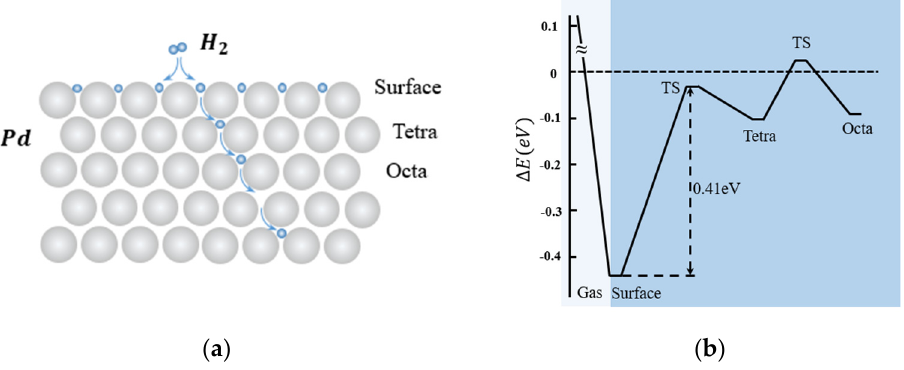
Figure 1. ( a ) Illustration of hydrogen adsorption in Pd (100) [16]; ( b ) diagram of the potential energy profile of hydrogen-absorption [17]. Copyright (2017), with permission from American Chemical